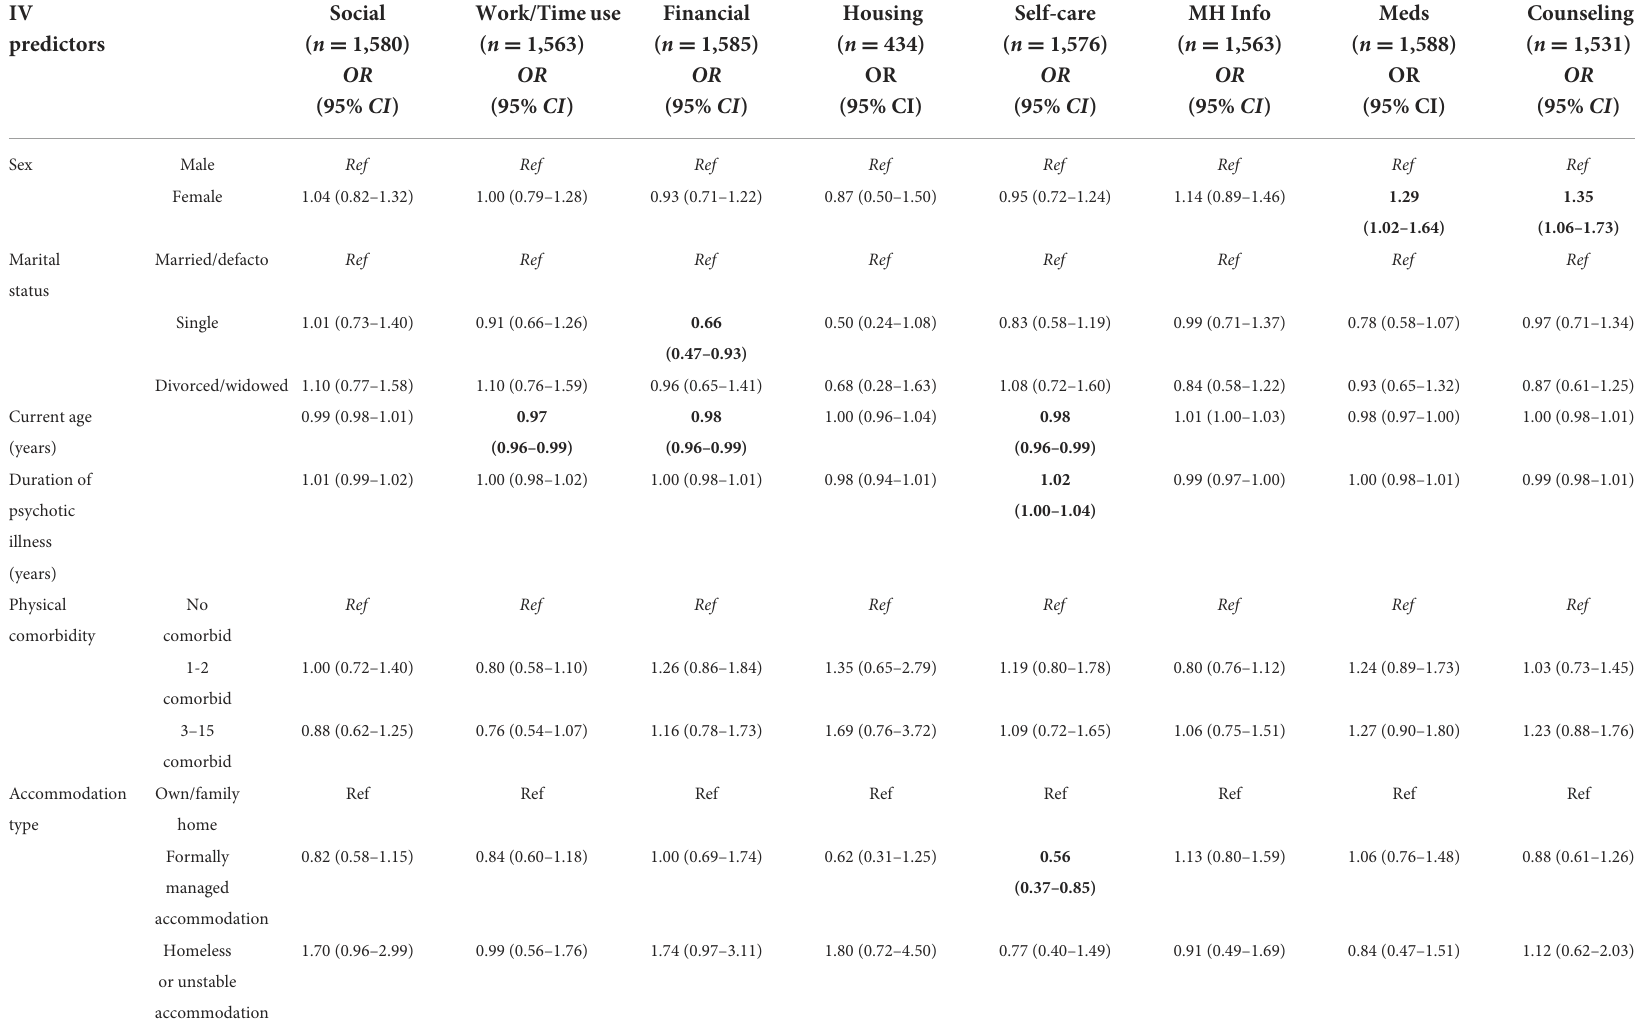
TABLE 4 Binary logistic regressions (all sample): Odd ratios (OR) and confidence intervals (CIs) predicting the outcomes of inadequately or unmet need response per PNCQ